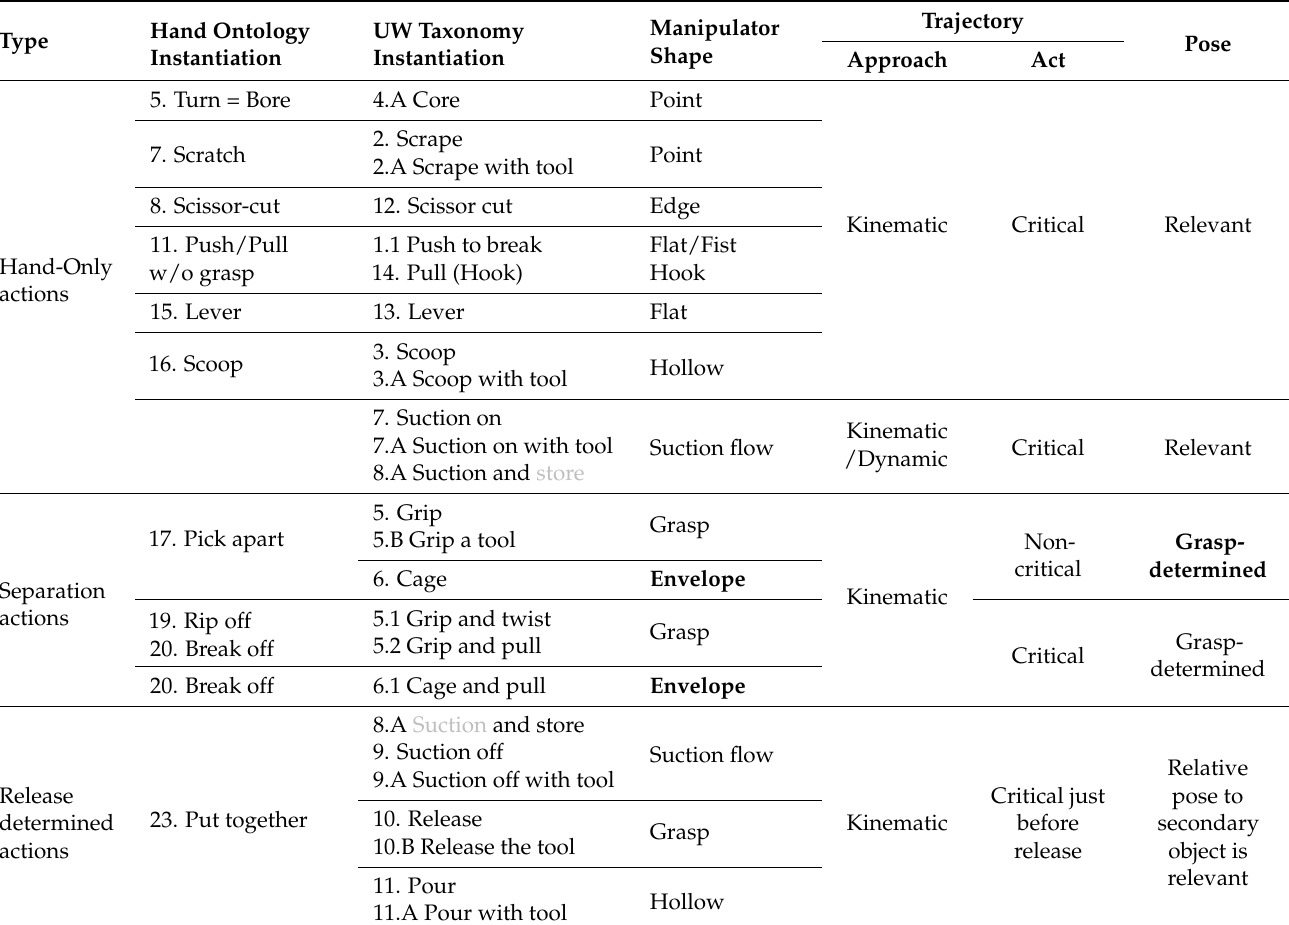
Table 4. Framing taxonomy of underwater (UW) manipulative actions into the human hand ontology of action identified in [19]. Action 8.A is composed of a first part “Suction and . . . ” classified as a hand-only action, and a second part “ . . . and store” classified as a release-determined action. In bold , the modification and additions introduced in the analysis of the manipulation features with respect to